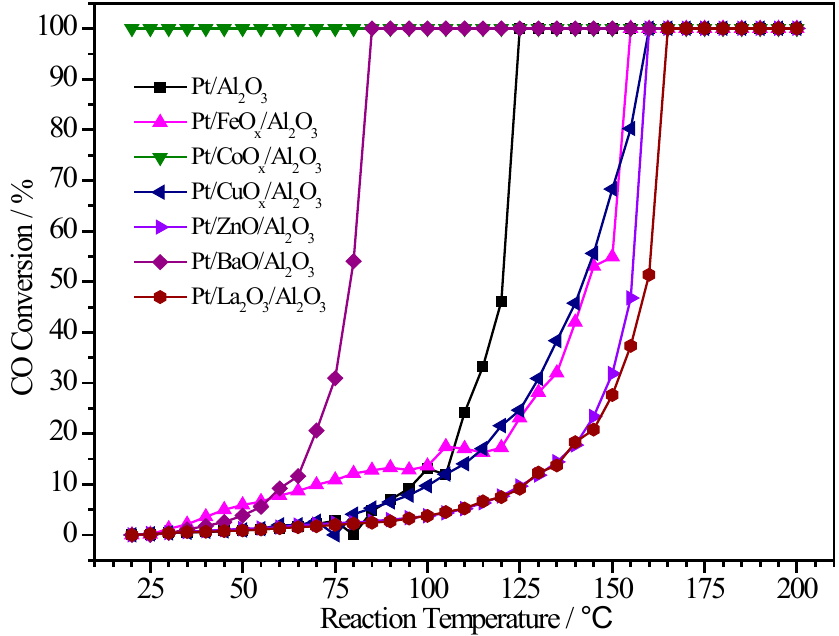
Figure 5. CO conversions on Pt/MO x /Al 2 O 3 catalysts as a function of reaction